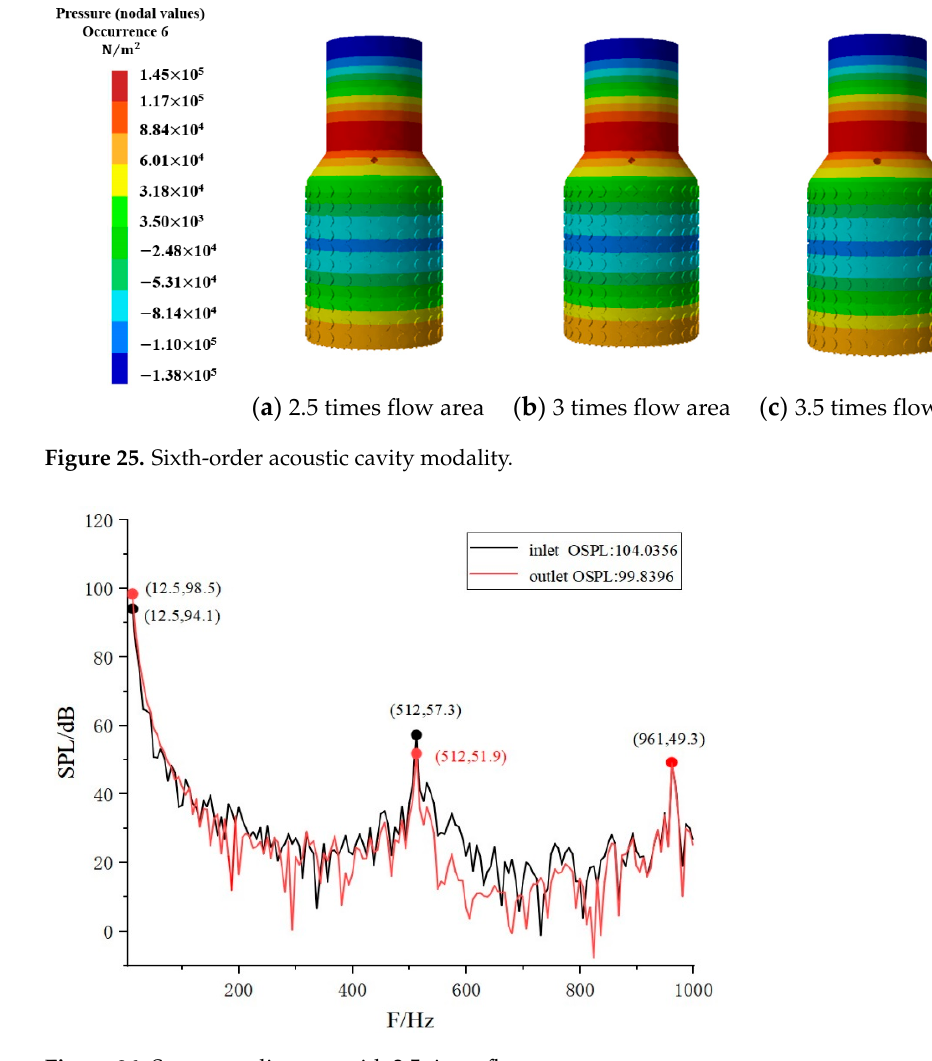
Figure 27. Spectrum diagram with 3 times flow area.